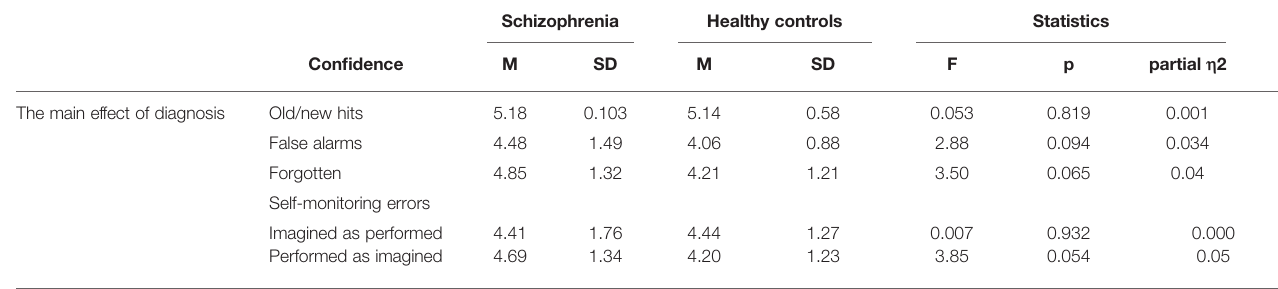
TABLE 7 | The main effect of type of scale (CR vs. PDW) on con fi dence